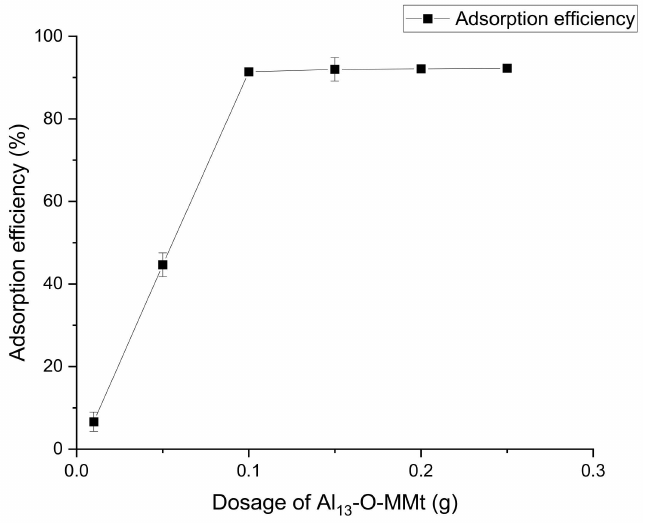
Figure 5. Dosage of Al 13 -O-MMt used in the adsorption of 30 mL 200 mg/L phosphorus solution with pH = 8, related to adsorption